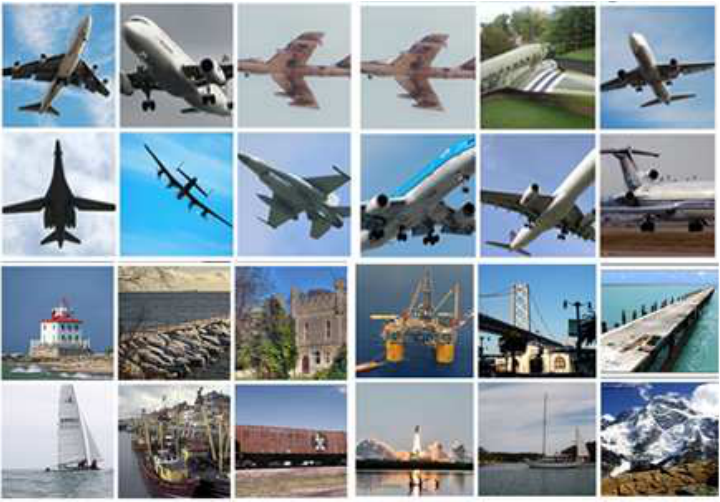
Figure 17. Examples of the NATURE-PLANE dataset used in the transfer learning of the objNet